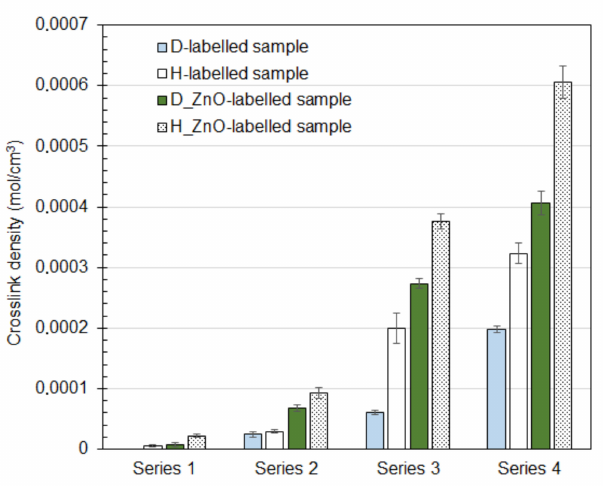
Figure 3. Crosslink density (expressed as moles of crosslinks per cm 3 of a polymer network) of the coating films based on latexes, differing in the covalent crosslinking strategy, surfactant type and nanostructured ZnO